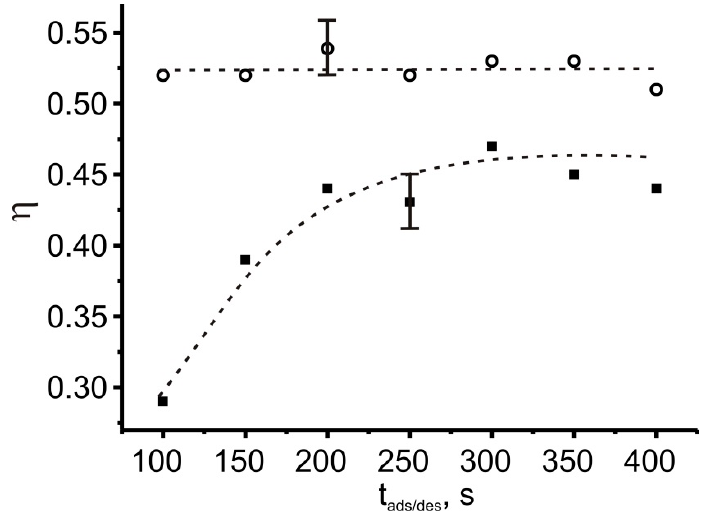
Figure 11. Variation of experimental (closed symbols) and formal (opened symbols) thermal efficiency with change in the duration of the adsorption–desorption stage.